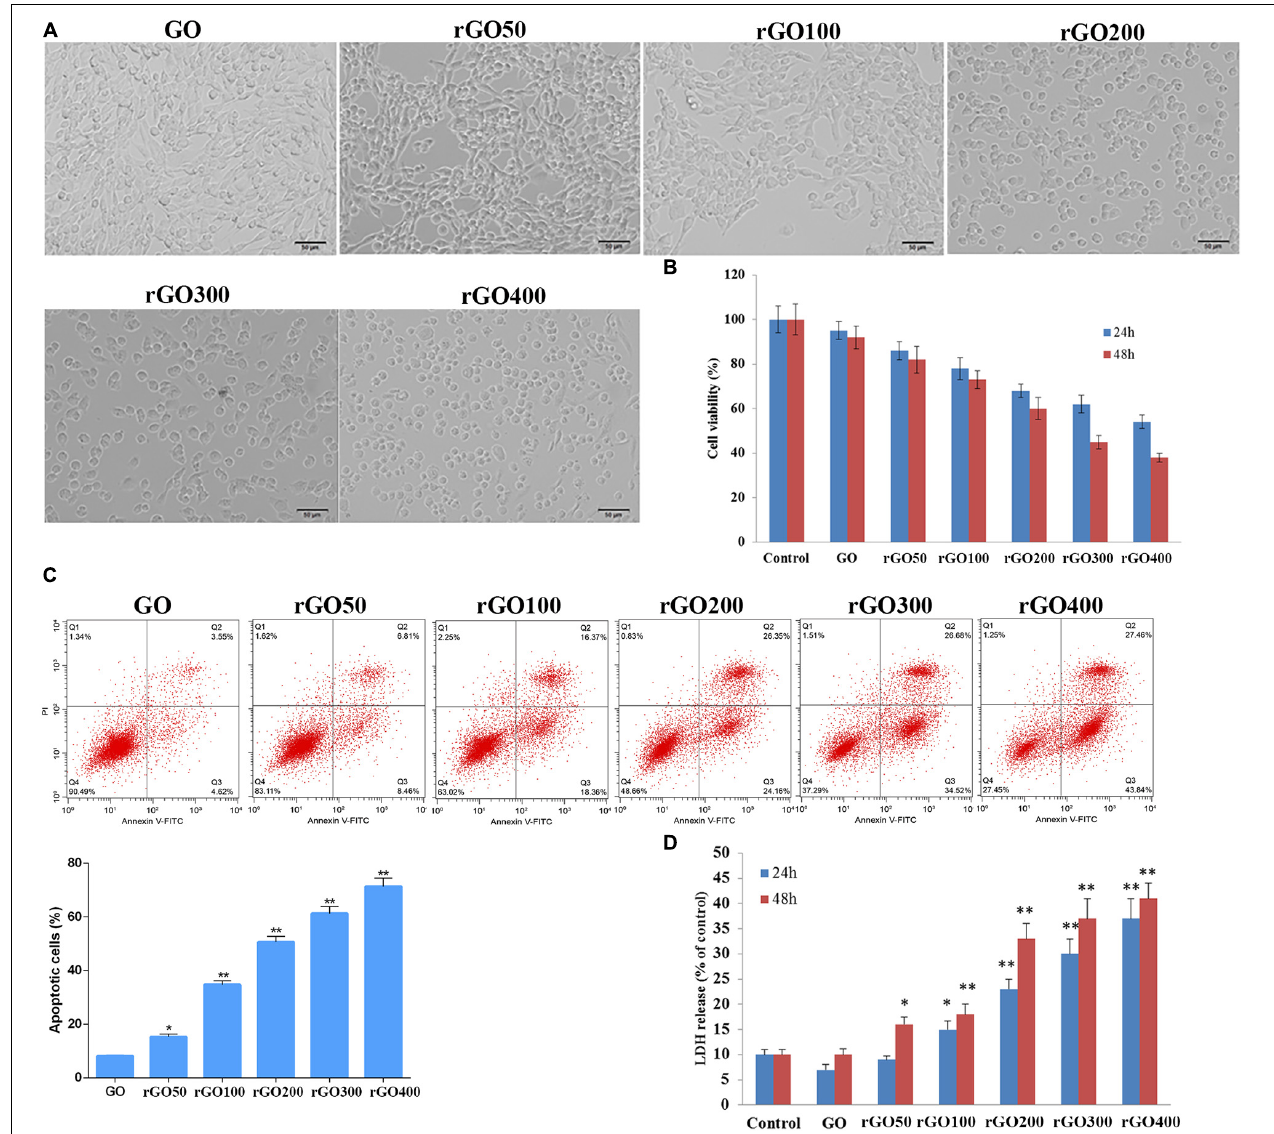
FIGURE 2 | Cytotoxicity of graphene oxide (GO) and reduced GO (rGO) in H9C2 cells. (A) Cell morphology when H9C2 cells treated with GO or rGO. (B) Cell viability of H9C2 cells treated with GO or rGO at 24 and 48 h using MTT assay ( n = 3). (C) Cell apoptosis rate of H9C2 cells treated with GO or rGO at 24 h using flow cytometry analysis ( n = 3). (D) Lactate dehydrogenase (LDH) release of H9C2 cells treated with GO or rGO at 24 and 48 h using the commercial kit ( n = 3). * p < 0.05; ** p <